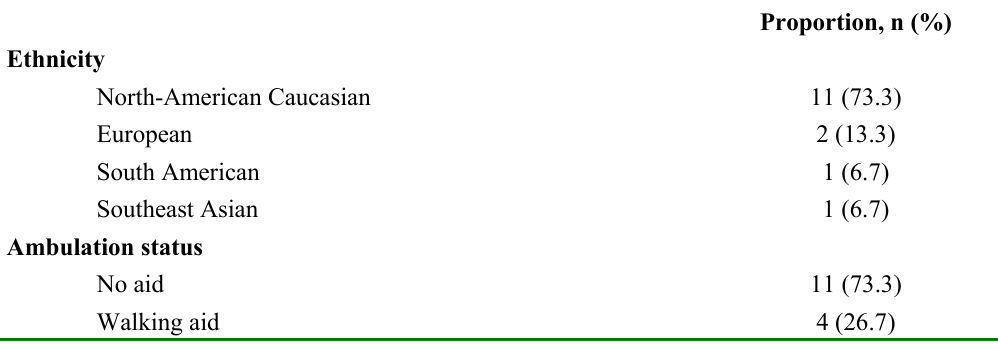
Table 1. Descriptive characteristics of participants (N =